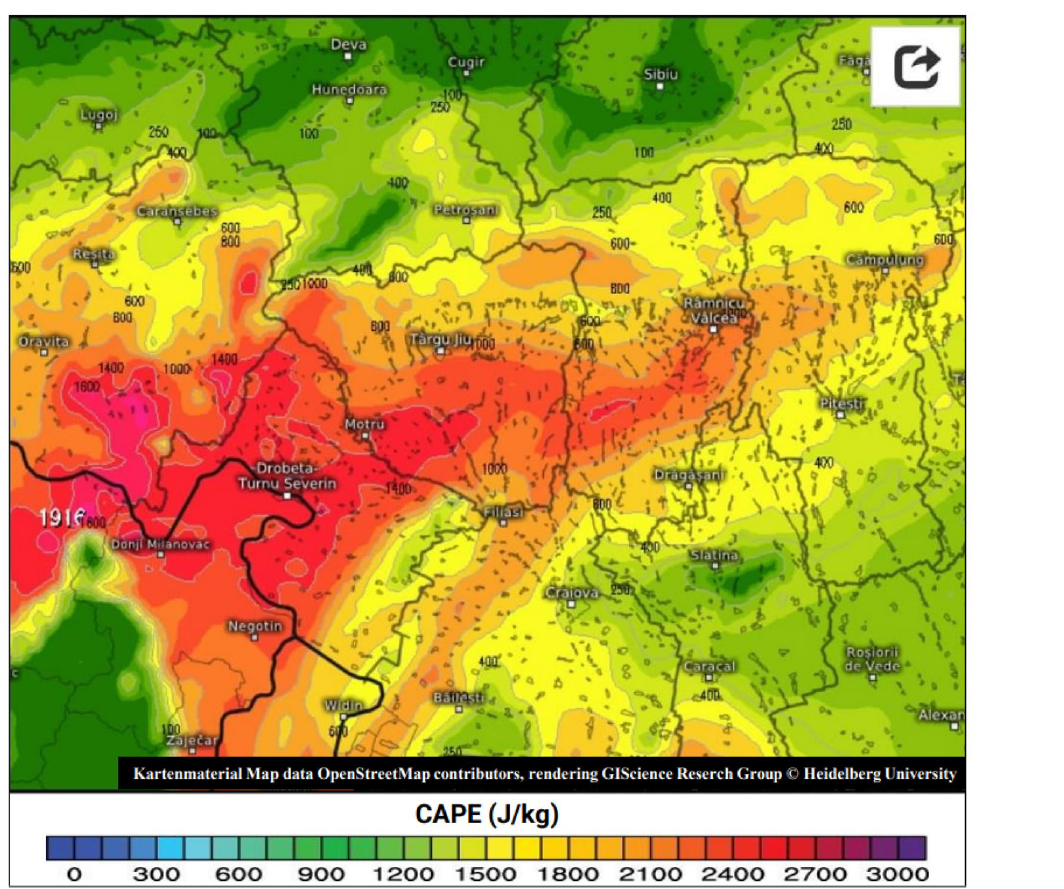
Figure 16. Map showing the CAPE instability index acquired on 20/05/2020 at 17:00. Colors indicate instability index CAPE. Source: https:// kache lmann wetter. com/ de/ info/ niede rschl agsra